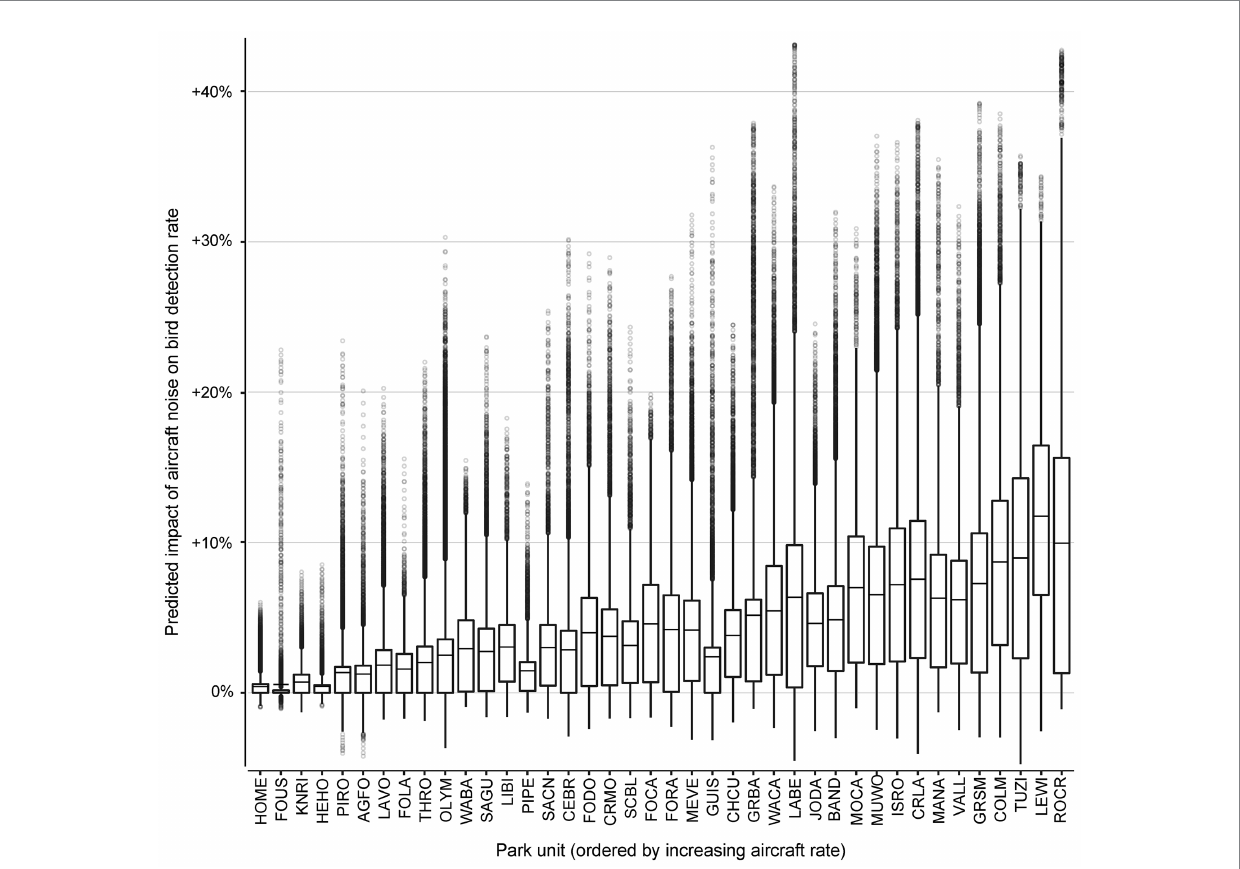
FIGURE 4 Projected influence of observed aircraft noise across 40 National Park units on bird detection probabilities relative to predicted rates under ‘no aircraft noise’ conditions. The park units have been ordered along the x -axis by increasing mean probability of aircraft detection. Points above 0 on the y -axis represent audio surveys that were predicted to have increased probability of bird detection under observed ‘aircraft noise’ conditions, while points below 0 on the y -axis represent audio surveys predicted to have decreased probability of bird detection under ‘aircraft noise’ conditions. The middle line is the mean difference in bird detection probability at each park unit. The lower hinge is the 25-percent quantile, and the upper hinge is the 75-percent quantile. The distance between the lower and upper hinges is the inter-quartile range (IQR). The whiskers mark the most discrepant observations that are within 1.5*IQR of the nearest hinge value. National Park unit abbreviations are Agate Fossil Beds National Monument (AGFO), Bandelier National Monument (BAND), Cedar Breaks National Monument (CEBR), Chaco Culture National Historical Park (CHCU), Colorado National Monument (COLM), Crater Lake National Park (CRLA), Craters of the Moon National Monument (CRMO), Fort Caroline National Memorial (FOCA), Fort Donelson National Battlefield (FODO), Fort Laramie National Historic Site (FOLA), Fort Raleigh National Historic Site (FORA), Fort Union Trading Post National Historic Site (FOUS), Great Basin National Park (GRBA), Great Smoky Mountains National Park (GRSM), Gulf Islands National Seashore (GUIS), Herbert Hoover National Historic Site (HEHO), Homestead National Monument of America (HOME), Isle Royale National Park (ISRO), John Day Fossil Beds National Monument (JODA), Knife River Indian Villages National Historic Site (KNRI), Lava Beds National Monument (LABE), Lassen Volcanic National Park (LAVO), Lewis and Clark National Historical Park (LEWI), Little Bighorn Battlefield National Monument (LIBI), Manassas National Battlefield Park (MANA), Mesa Verde National Park (MEVE), Montezuma Castle National Monument (MOCA), Muir Woods National Monument (MUWO), Olympic National Park (OLYM), Pipestone National Monument (PIPE), Pictured Rocks National Lakeshore (PIRO), Rock Creek Park (ROCR), Saint Croix/Lower St. Croix National Scenic River (SACN), Saguaro National Park (SAGU), Scotts Bluff National Monument (SCBL), Theodore Roosevelt National Park (THRO), Tuzigoot National Monument (TUZI), Valles Caldera National Preserve (VALL), Washita Battlefield National Historic Site (WABA), Walnut Canyon National Monument